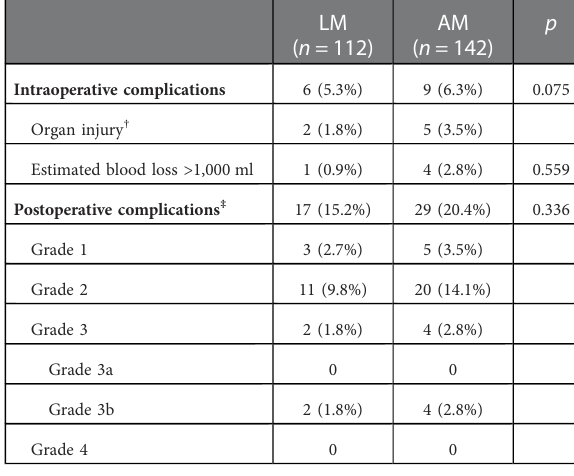
TABLE 2 Comparison of the intraoperative and postoperative complications between laparoscopic myomectomy and abdominal